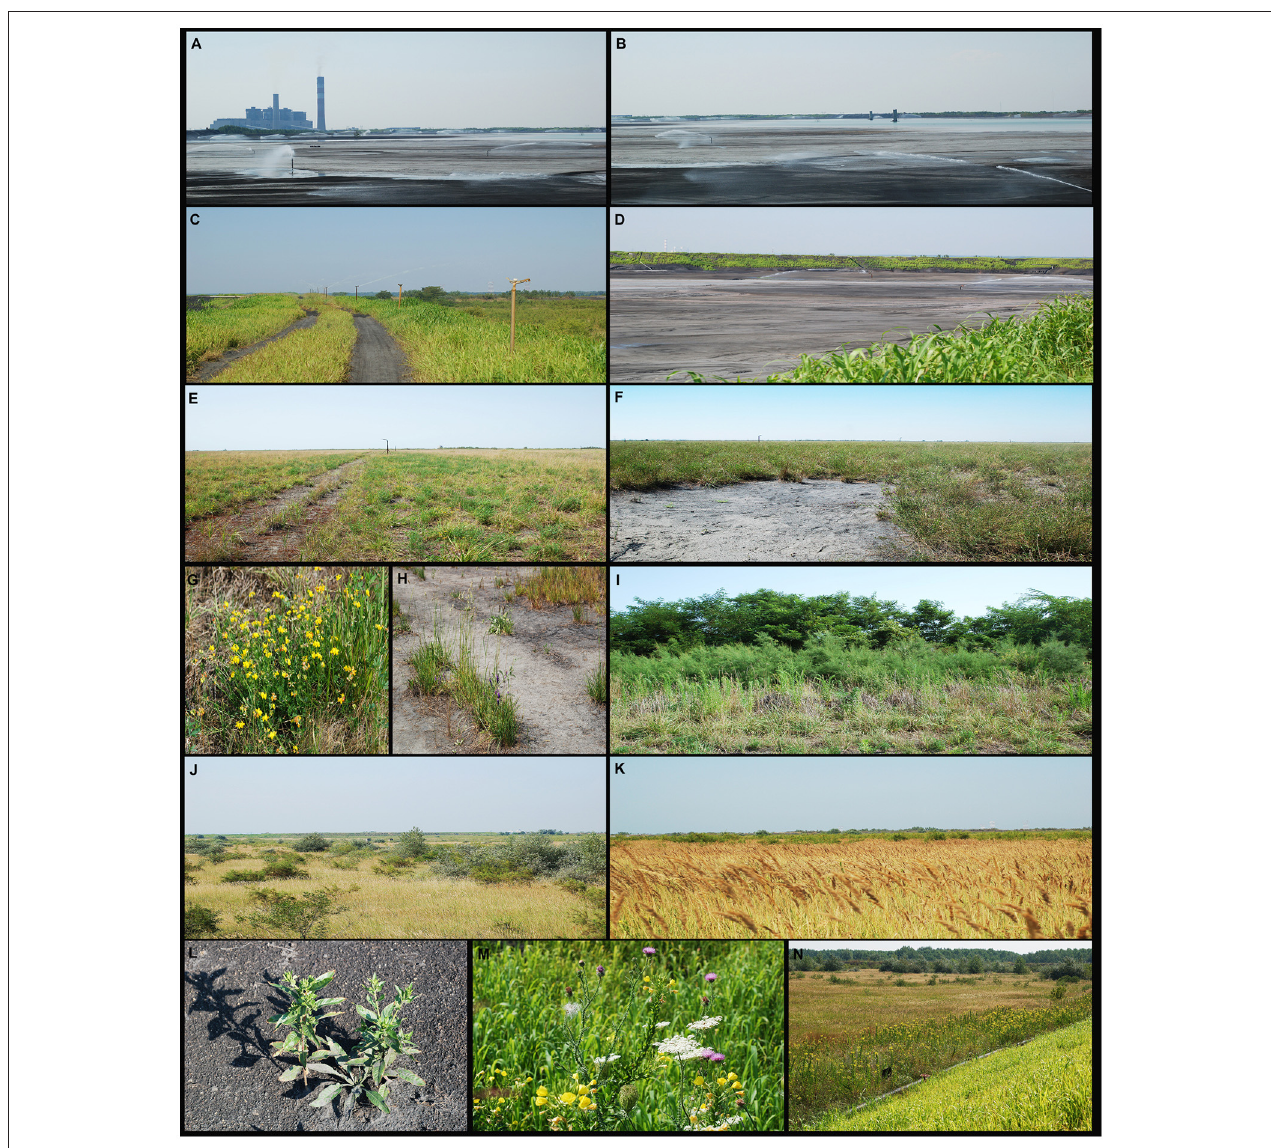
FIGURE 1 | Fly ash deposits at the thermoelectric plant station ”Nikola Tesla-A” (TENT-A) in Obrenovac (Serbia): active cassette of fly ash (A–D) ; passive cassette of fly ash 3 years after biorecultivation with sown legumes, grassses, and shrubs (E–I) ; passive cassette of fly ash 11 years after biorecultivation with spontaneous colonizers (J–N)